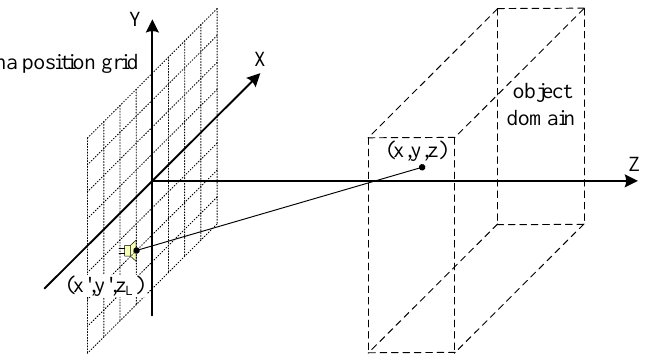
Figure 1. The setup of single antenna scanning scenario.